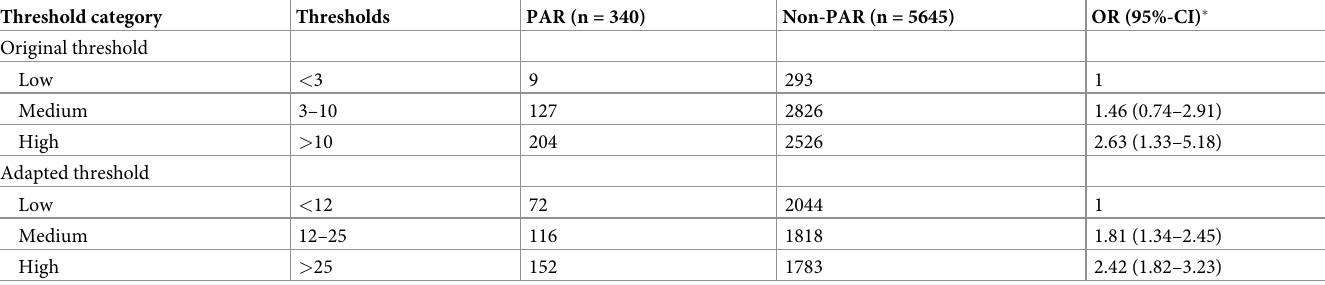
Table 3. Contingency table and odds ratios describing the association between risk group and potentially avoidable readmission